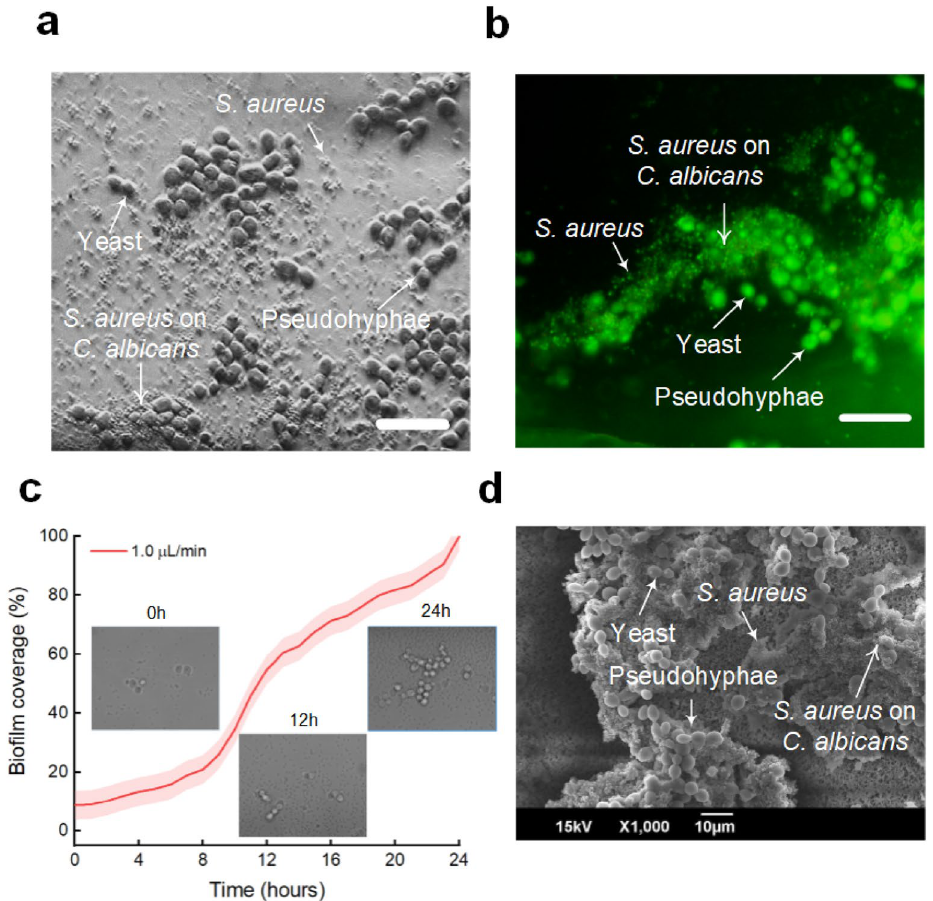
Figure 5. Biofilm coverage of dual-species biofilm formation ( S. aureus + C. albicans ): ( a ) bright-field image, ( b ) fluorescent image with SYTO-9 dye, ( c ) temporal development of biofilm coverage under a flow rate of 1 μL/ min, and ( d ) SEM image under static conditions (scale bar = 20